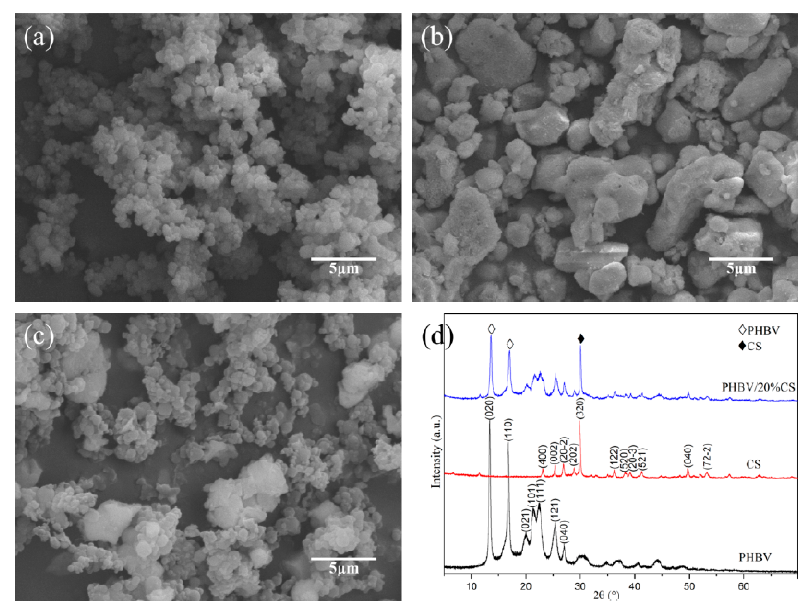
Figure 1. SEM (scanning electron microscope) morphologies of ( a ) PHBV; ( b ) CS; and ( c ) PHBV/20%CS composite powders and ( d ) the corresponding XRD (X-ray diffraction) patterns.